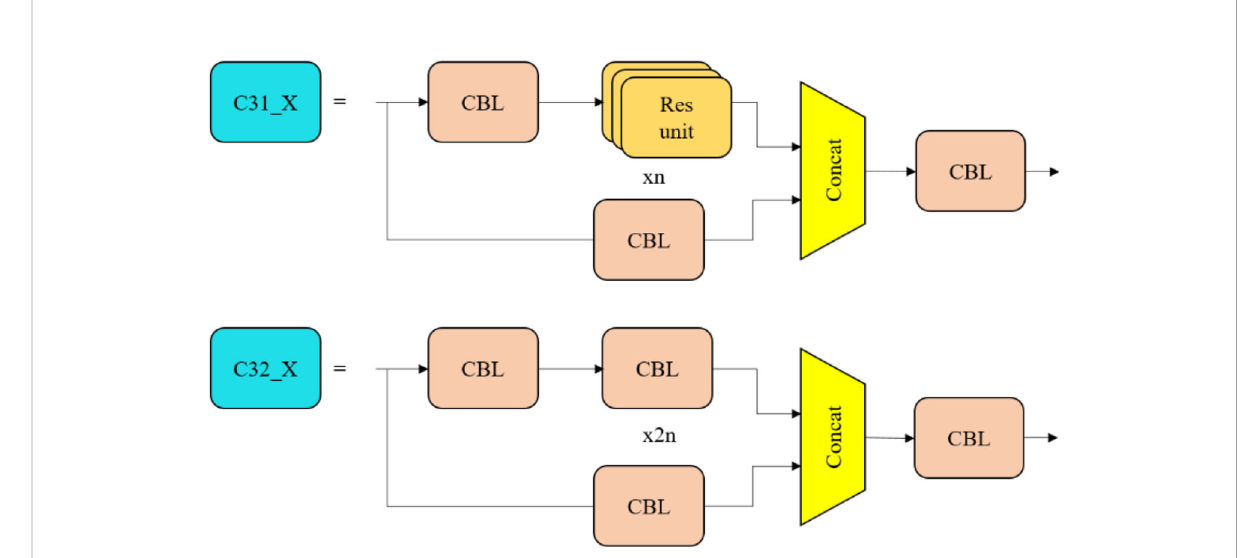
FIGURE 4 The C3